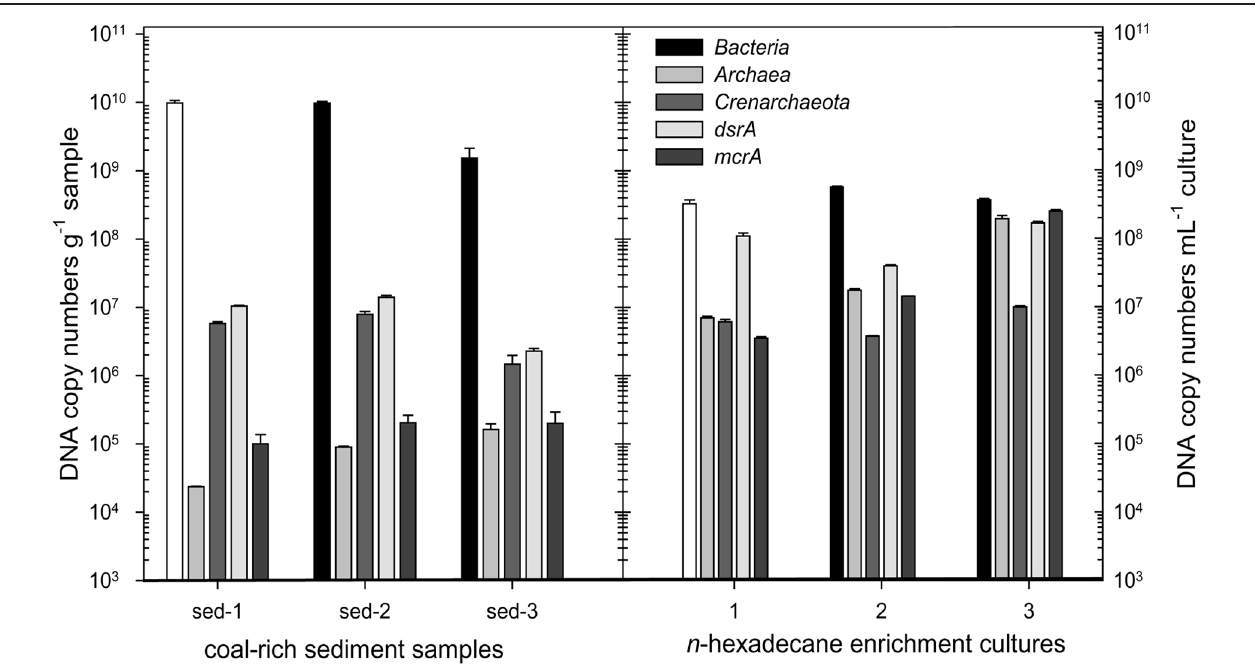
FIGURE 3 | Abundance of Bacteria , Archaea , Crenarchaeota, sulfate-reducing prokaryotes ( dsrA ) and methanogens ( mcrA ) in coal-rich sediment samples and their derived n -hexadecane-amended enrichment cultures, as determined by quantitative PCR. The error bars represent the SD of three